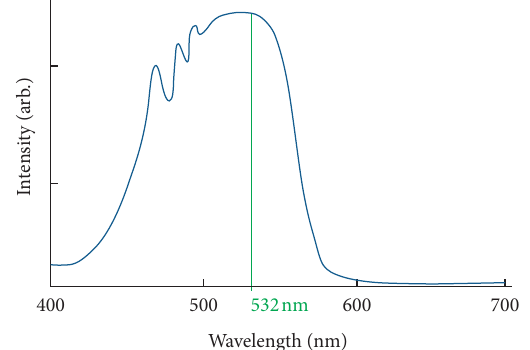
Figure 1: Absorption spectrum of PE-dye-doped polystyrene